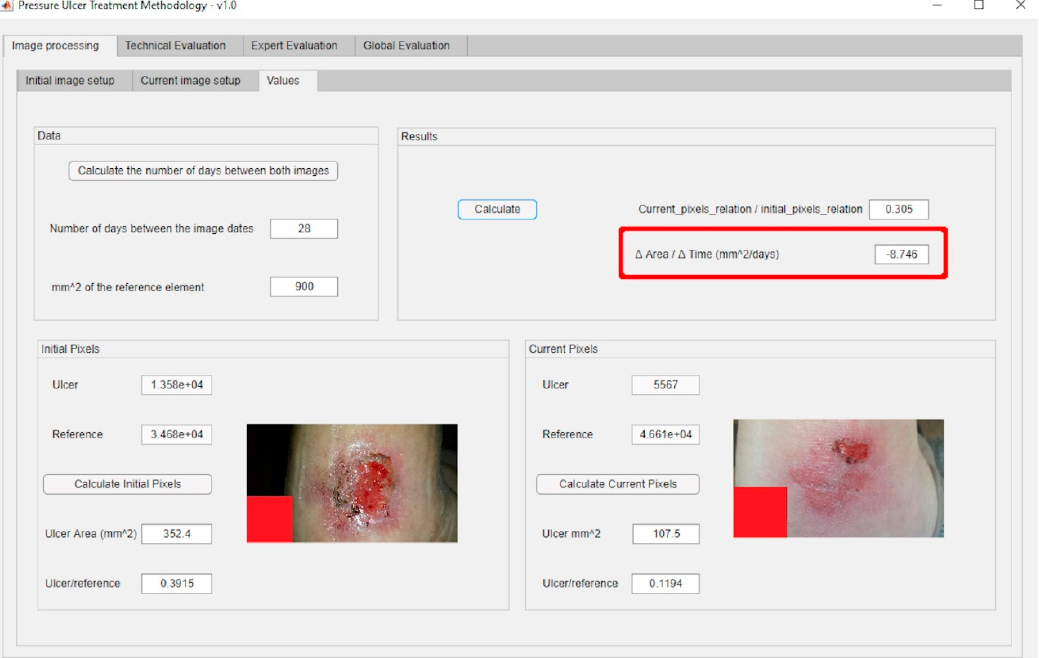
Figure 19. Image processing: ( a ) initial picture; ( b ) current picture.